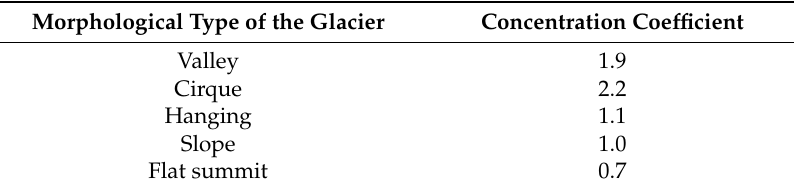
Table 3. Average coefficient of snow concentration on the firn lines of the glaciers of the Mongun-Taiga